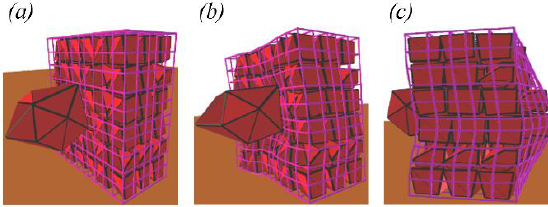
Fig. 4 Gabion basket impacted by boulder using PRISM method. (a) Initial conditions; (b) front view of impact; (c) profile view of